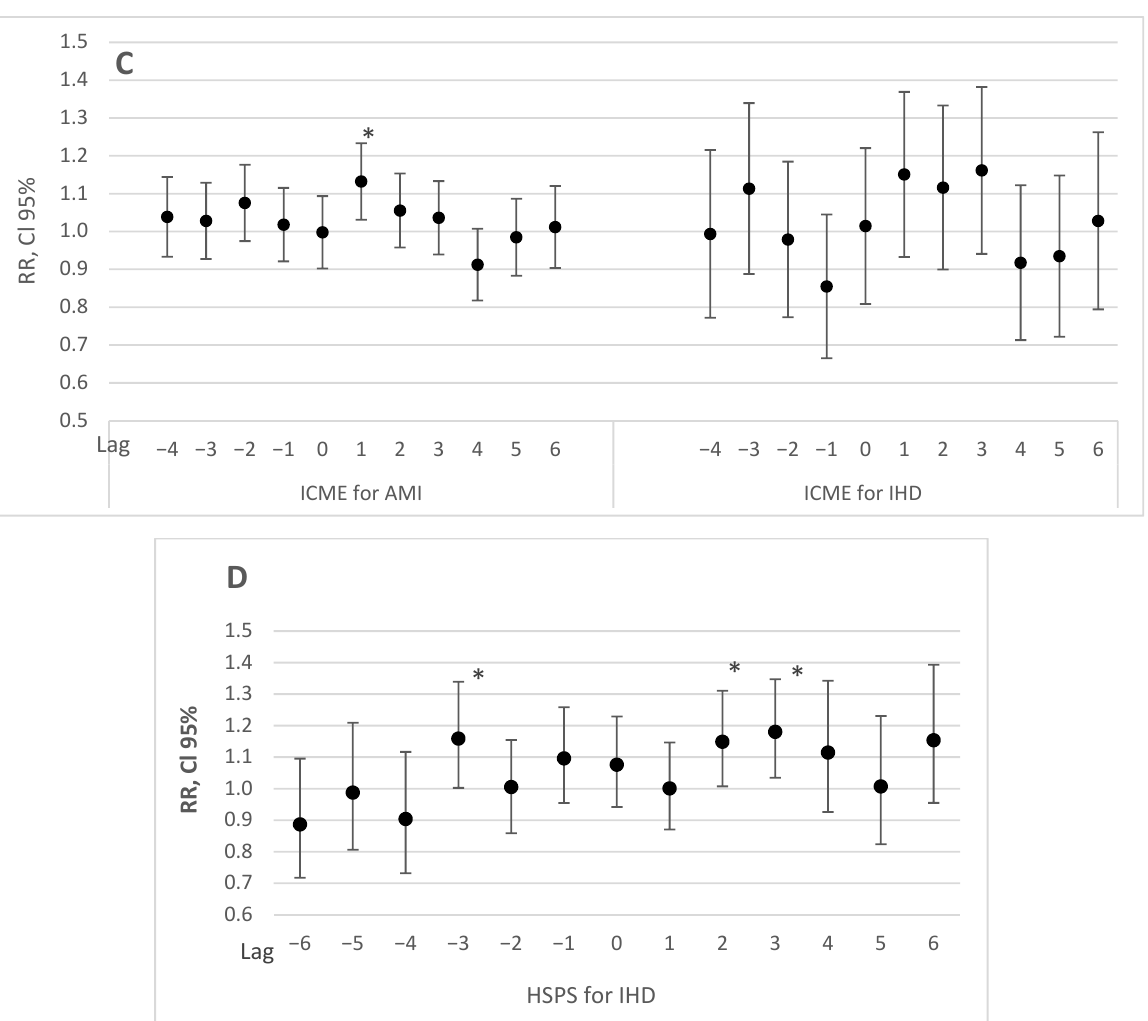
Figure 3. The superposed epoch analyses of the rate ratios for AMI and death from IHD with the key days being the GSs ( A ), SPEs ( B ), ICMEs ( C ), and HSPSs ( D ) (RRs with 95% CI in the multivariate model). Zero corresponds to the day of the onset of the stormy period, the period of ICME, HSPS, and SPE. * p < 0.05.